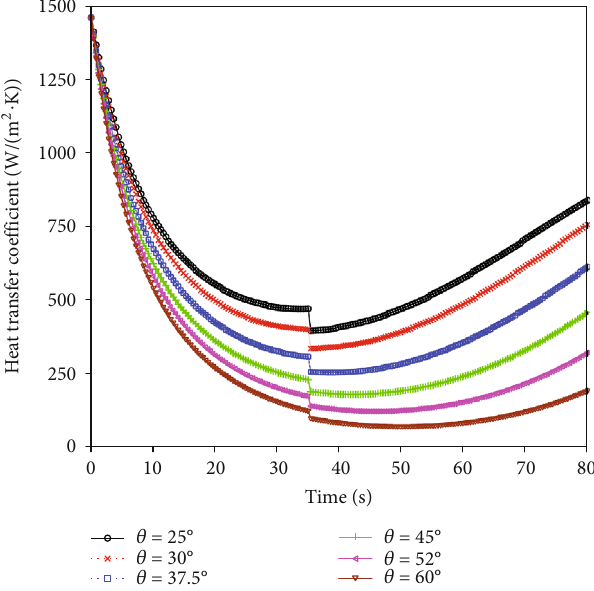
Figure 12: Average coe ffi cients of convection heat transfer at di ff erent launch